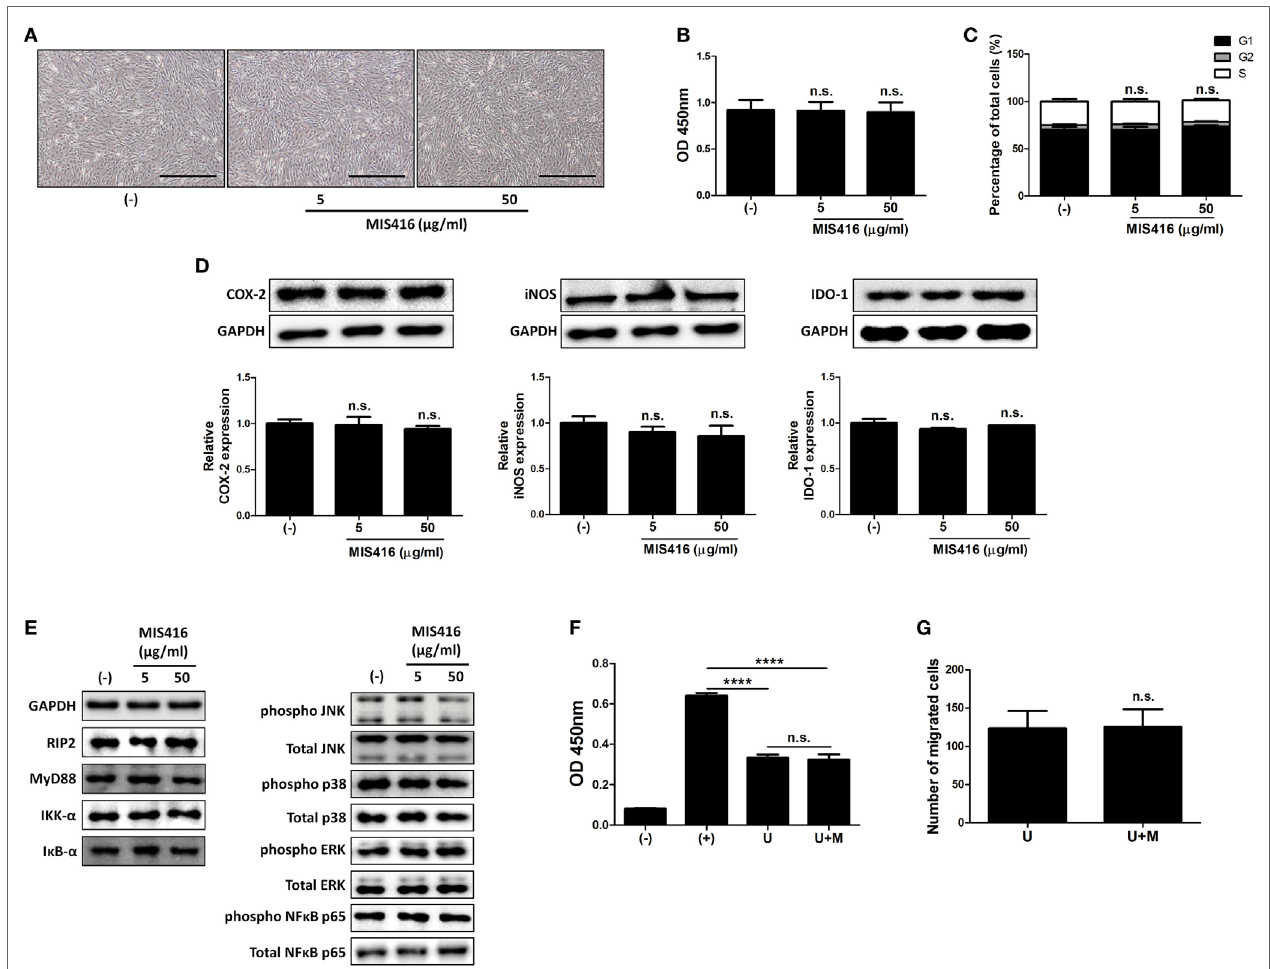
FigUre 3 | MIS416 does not have direct effect on the properties of human adult stem cells, including umbilical cord blood-derived mesenchymal stem cells (hUCB-MSCs) including immunomodulatory functions in vitro . (a–e) hUCB-MSCs were treated with indicated concentrations of MIS416 for 24 h and further analyses were conducted. (a) Representative of bright-field microscopy images of hUCB-MSCs, bar = 500 µm. (B) Proliferation of hUCB-MSCs was determined by BrdU ELISA kit. (c) Cell cycle assay. (D) The relative expression levels of COX2, iNOS, and IDO-1 in hUCB-MSCs were analyzed by immunoblotting analysis. (e) (Left) Expression levels of RIP2, MyD88, IKK- α , and I κ B- α /(Right) phosphorylation levels of NF κ B p65, p38 mitogen-activated protein kinase, ERK, and JNK were determined by western blot analysis. (F) Mixed lymphocytes reaction assay of hUCB-MSCs. (g) Transwell migration assay was performed and migrated cells were quantified. Gel electrophoresis was conducted under the same experimental conditions, and images of blots were cropped. Uncropped blot images are shown in Figure S7 in Supplementary Material. Experiments were performed in triplicate. ( − ): negative control group, ( + ): ConA activated group, U: hUCB-MSCs, U + M: MIS416-treated hUCB-MSCs. **** P < 0.0001. Results are shown as the mean ±